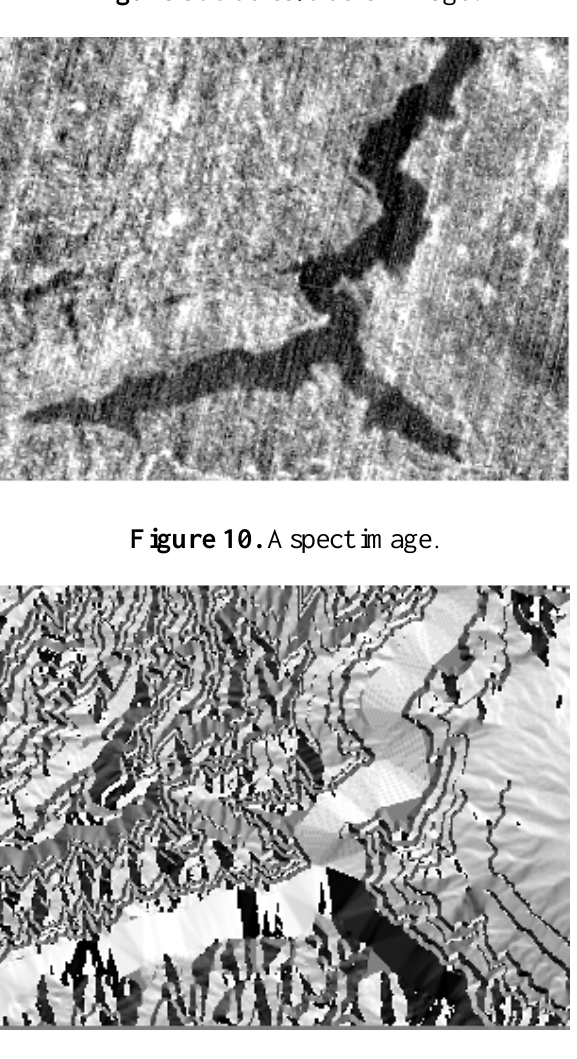
Figure 9. Cbers3/Cbers2 image.